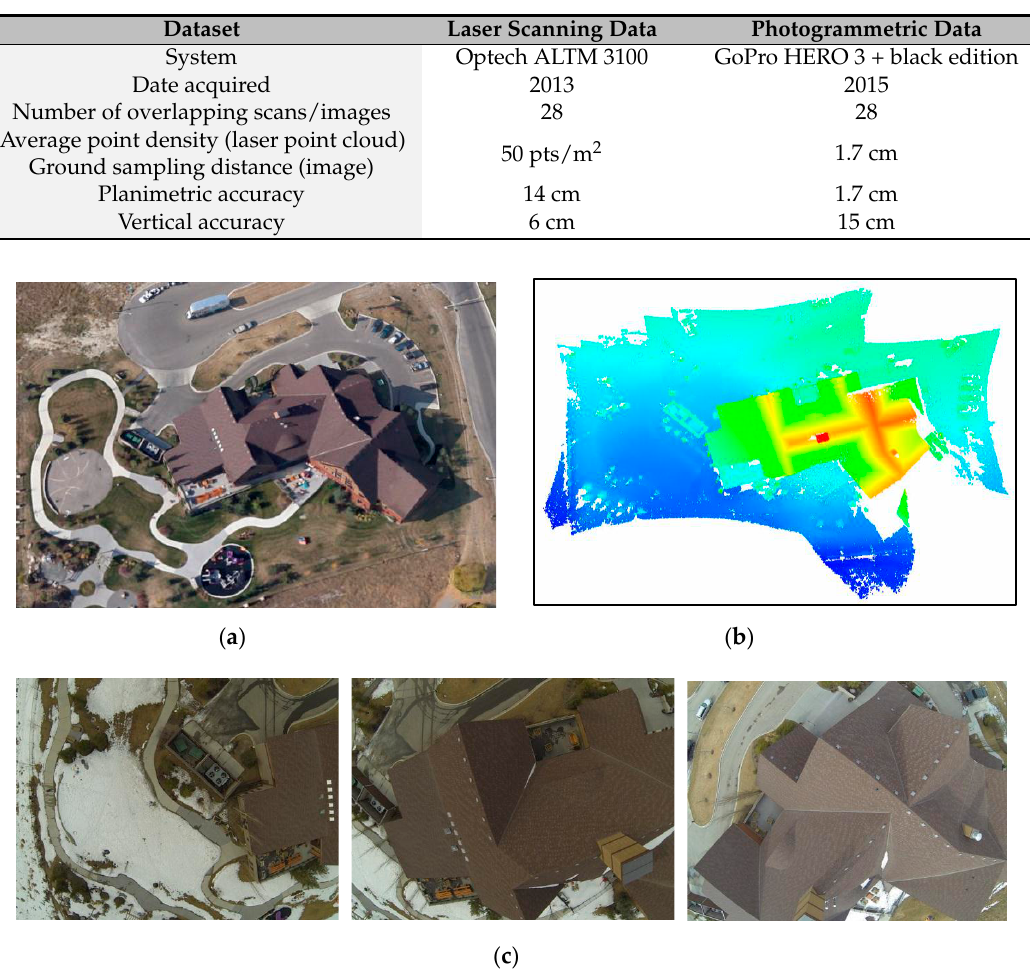
Table 3. A summary of the laser scanning point cloud and imagery characteristics utilized in the first experimental dataset.